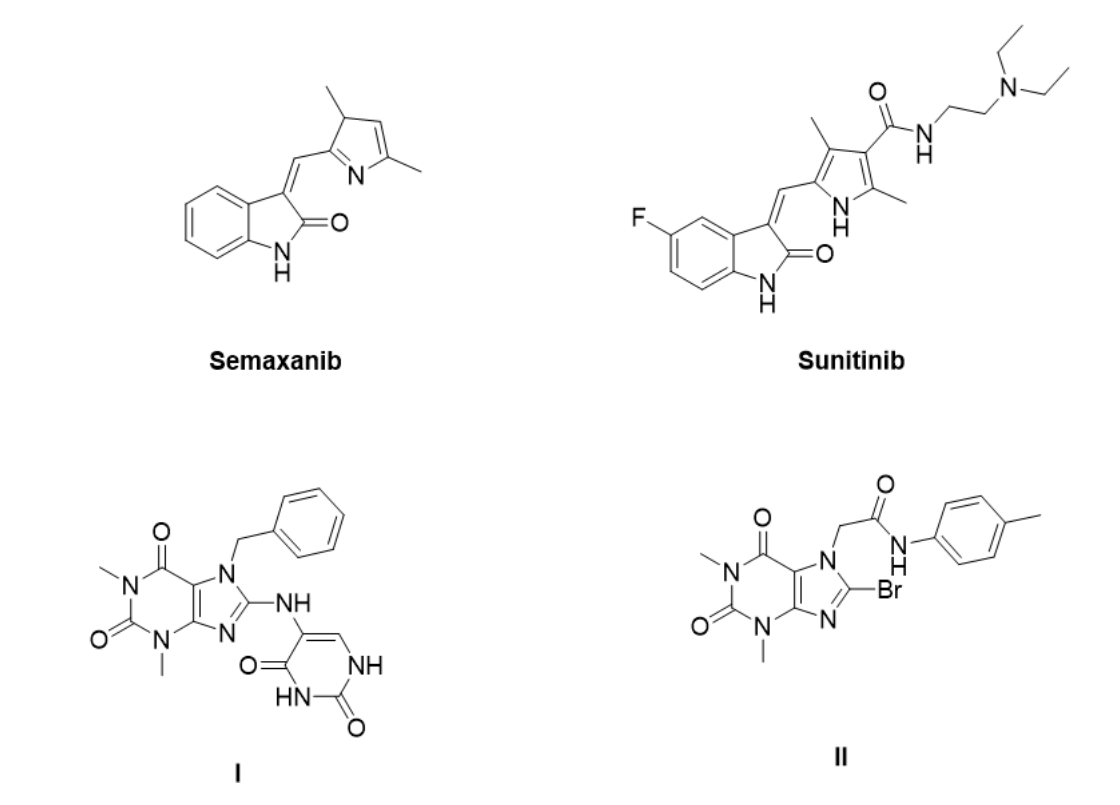
Figure 1. Compounds containing isatin scaffold or purine.